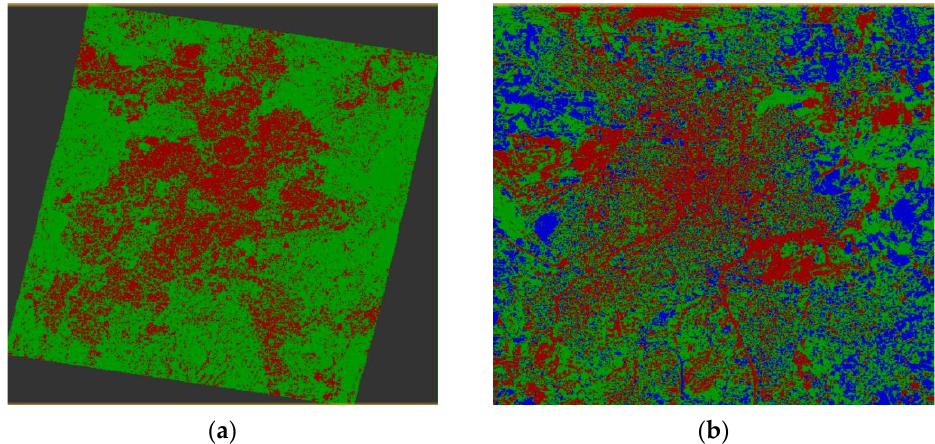
Figure 17. K-means unsupervised classification results in Nicosia as applied in ( a ) Sentinel-1; ( b ) Sentinel-2.